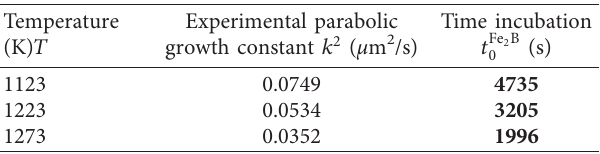
Figure 7: XRD pattern of AISI W2 boriding steel at a temperature of 1273K with 8 h of exposure time. Table 1: Experimental values of parabolic growth rate constants with the corresponding boride incubation time on AISI W2 by power pack